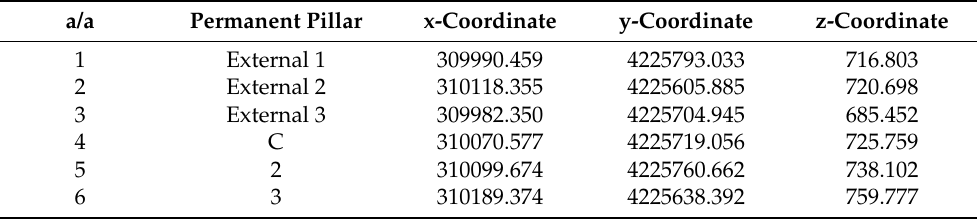
Table 4. Coordinates of